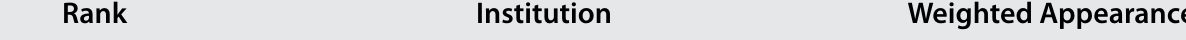
Table 10. Top Institutions Ranked by Weighted Appearances